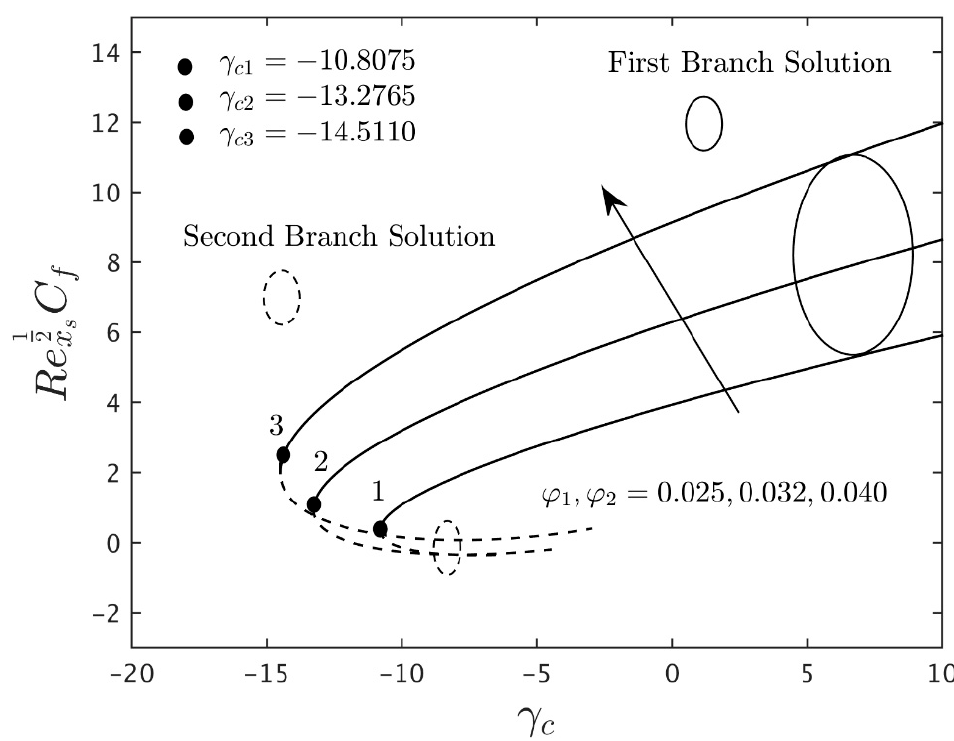
Figure 8. Variation of the skin friction coefficient with γ c for the several values of ϕ 1 and ϕ 2 .